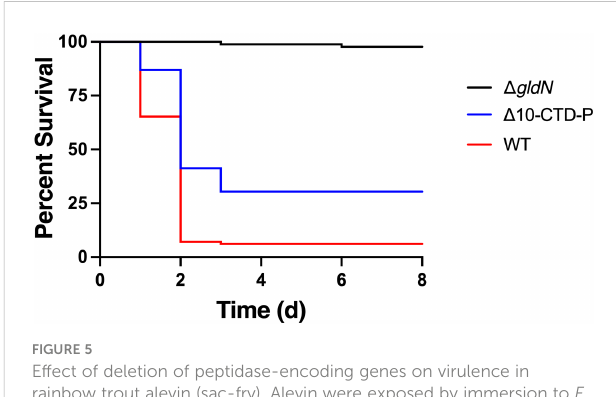
FIGURE 5 Effect of deletion of peptidase-encoding genes on virulence in rainbow trout alevin (sac-fry). Alevin were exposed by immersion to F. columnare strains and monitored for 8 d. The fi nal challenge concentrations were 6.9 × 10 6 CFU/mL (WT), 1.1 × 10 7 CFU/mL ( D gldN ), and 8.0 × 10 6 CFU/mL ( D 10-CTD-P). Signi fi cant differences in percent survival for fi sh challenged were observed between the WT and D 10-CTD-P ( P <0.0001).